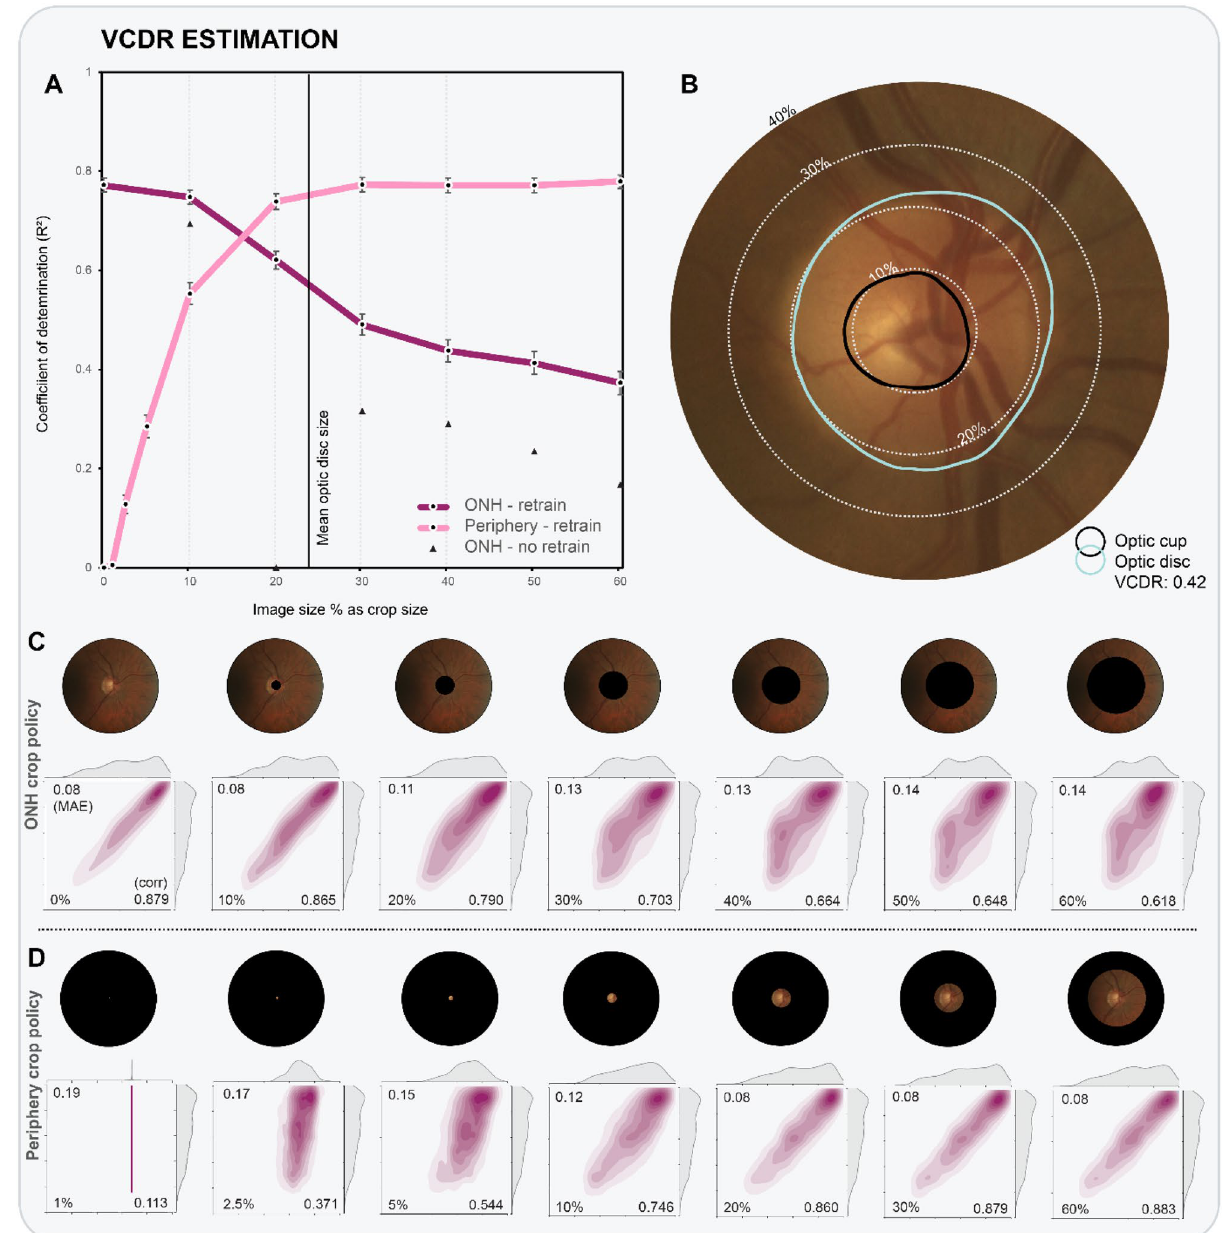
Evaluated crop sizes are indicated by data markers in the graph, and visualized in the two rows of fundus images. Results of occlusion are given as black triangles. ( B ) Close-up of example fundus image, with dotted lines corresponding to example crop sizes. (bottom panel) Detailed results for experiments following ONH cropping ( C ) and periphery cropping ( D ) policies. Kernel density estimation (KDE) plots with ground truth distribution on y-axis and prediction distribution on x-axis. The KDE plots also feature the MAE (top left), Pearson r (bottom right) and crop size (bottom